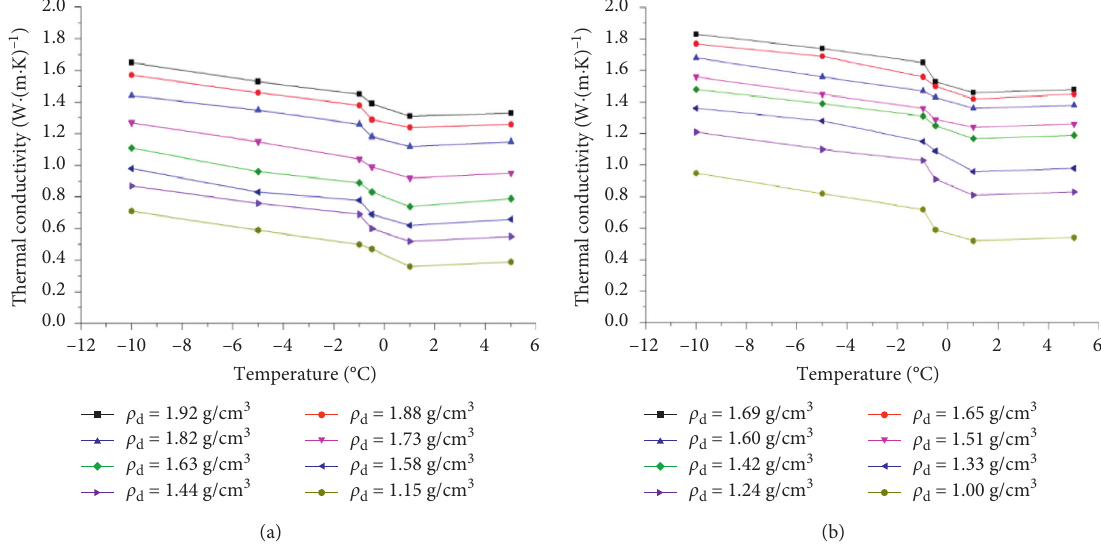
Figure 5: Variation of the thermal conductivity of the soil specimens with temperature. (a) w � 14%. (b) w �